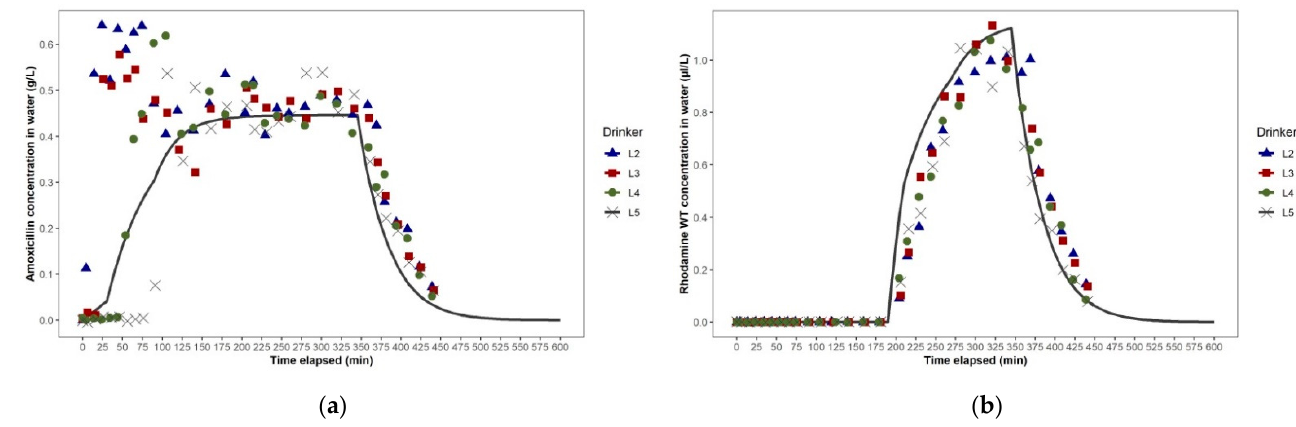
Figure 9. Study 2b dosing event in Building B: ( a ) amoxicillin concentration—time plots for drinkers L2, L3, L4 and L5, as predicted using EPANET (lines) and as observed (points), ( b ) rhodamine WT concentration—time plots for drinkers L2, L3, L4 and L5, as predicted using EPANET (lines) and as observed (points).